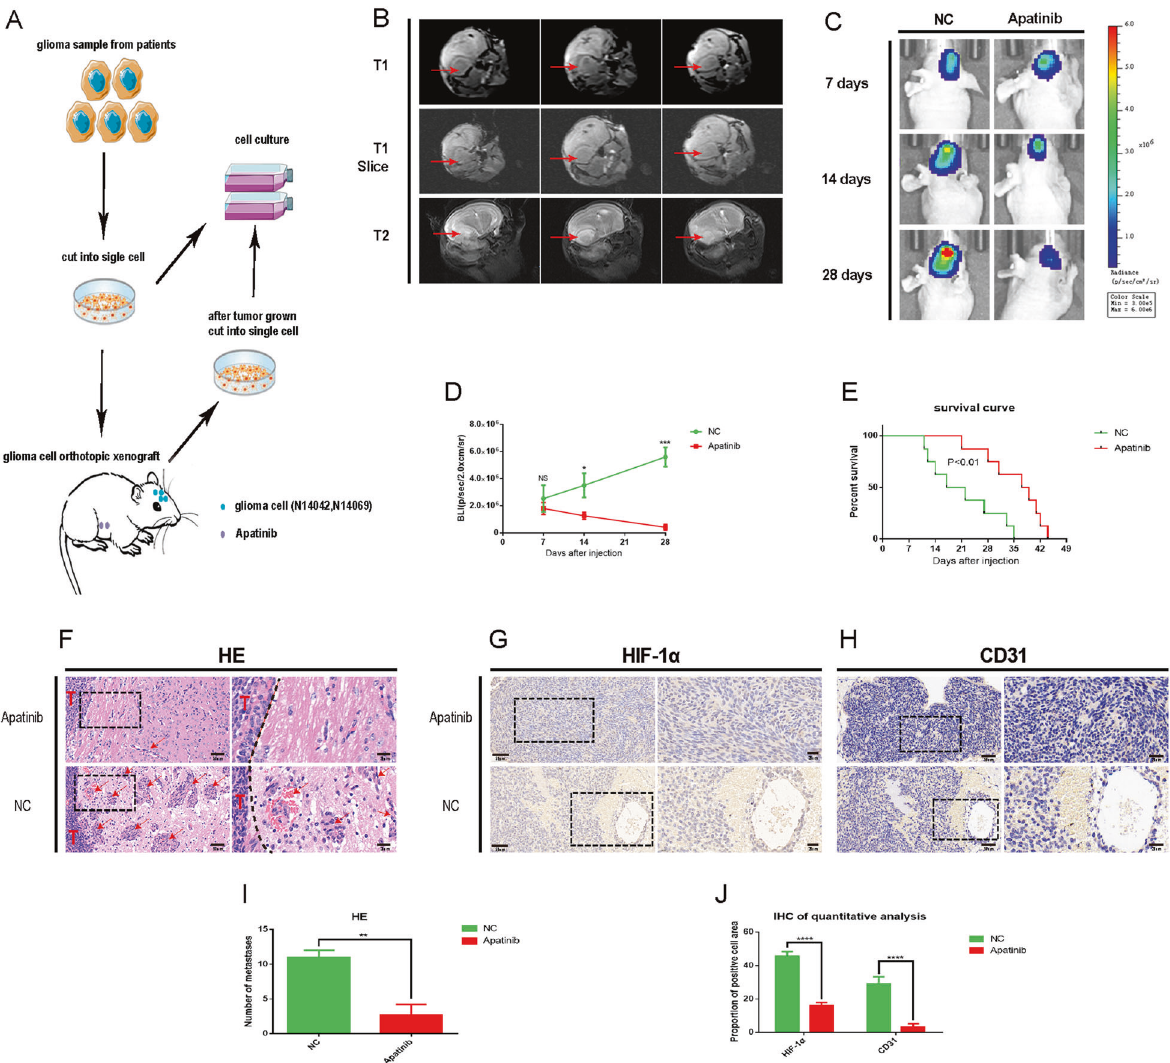
Fig. 1 Apatinib inhibits the progression of glioma cells in vivo. A Schematic diagram of patient-derived orthotopic xenograft (PDOX) model establishment. B Detection of mouse tumorigenesis by 3.0T nuclear magnetic resonance (NMR). C Representative images of bioluminescence in mice on days seven, 14, and 28 after cell implantation. D Quantitative analysis of bioluminescence images for the apatinib and control treatment groups. Data are shown as the mean ± standard deviation (SD), n = 3, *** p < 0.001, * p < 0.05, NS > 0.05, compared with the control, Student ’ s t test. E The overall survival (OS) of mice in the apatinib and control treatment groups. Data are shown as the mean ± standard deviation (SD), n = 8, *** p < 0.001, * p < 0.05, NS > 0.05, compared with the control, Student ’ s t test. F Hematoxylin & eosin (H&E) staining of mouse brain sections differences showed between apatinib and NC group. T represents the tumor, the dotted line represents the boundary between the tumor and normal brain tissue, and red arrows indicate metastases. Representative immunohistochemistry (IHC) staining images of G CD31, and H HIF-1 α in tumor sections of apatinib and normal control (NC) groups. I Quantitative analysis of H&E staining images regarding the number of metastases in the apatinib and negative control groups. Data are shown as mean ± standard deviation (SD), n = 3, # p = NS, * p < 0.05, ** p < 0.01, *** p < 0.001, **** p < 0.0001, Student ’ s t test. J Quantitative analysis of the IHC results concerning the proportion of CD31 and HIF-1 α -positive cells in the apatinib and negative control groups. Data are shown as the mean ± SD, n = 3, ** p < 0.01 compared with the control, analysis of variance (ANOVA)